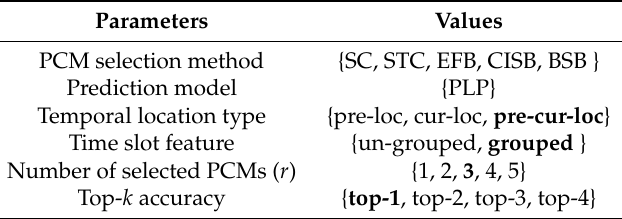
Table 5. Setup for the location prediction framework.